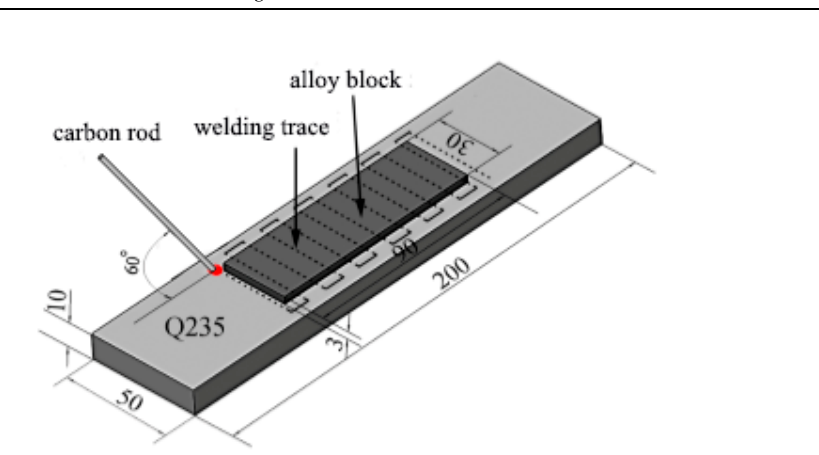
Figure 1. Schematic diagram of the carbon arc surfacing (Unit: mm).